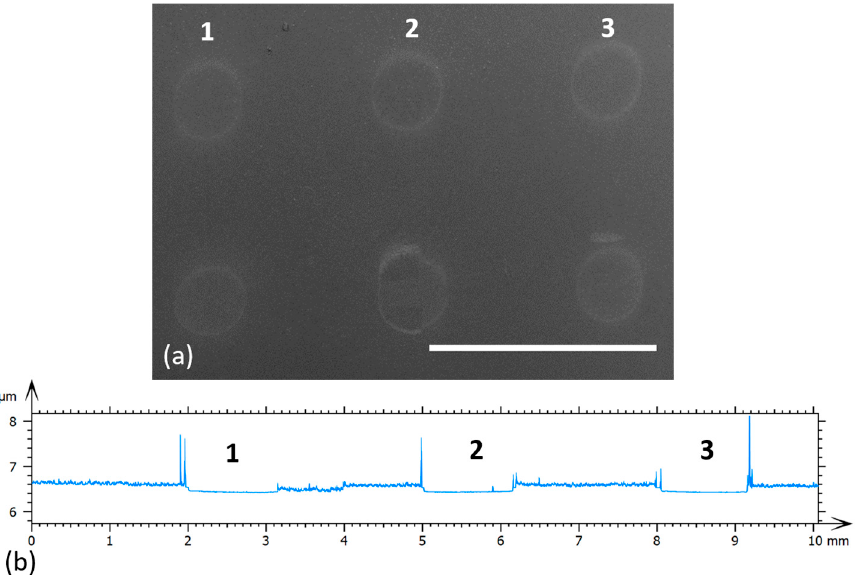
Figure 2. ( a ) Top-view SEM micrographs of 25:75 wt.% PEDOT:PSS: GO pixels transferred at different laser fluences, i.e., from left to right, 450 mJ/cm 2 , 600 mJ/cm 2 (middle), and 750 mJ/cm 2 on glass substrates. The transfer is carried out with the donor and receiver substrates in contact. The scale bar is 3 mm. ( b ) Profilometry traces of the ablated spots created by a single pulse in the 80 nm thick donor film of PEDOT:PSS: GO at three increasing laser fluences of 450, 600, and 750 mJ/cm 2 (from right to left). The profilometry traces correspond to pixels 1, 2, and 3 from ( a